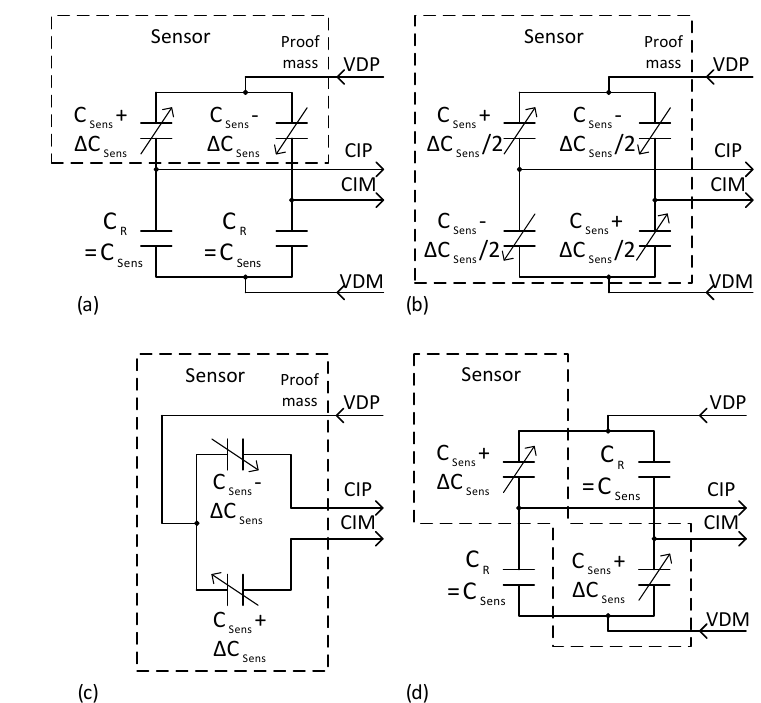
Figure 7. Connection schemes for different types of sensing elements: (a) differential sensing element using reference capacitors; (b) fully differential sensing element without external devices; (c) differential sensing element with low nominal capacitance and (d) single-ended sensing element.